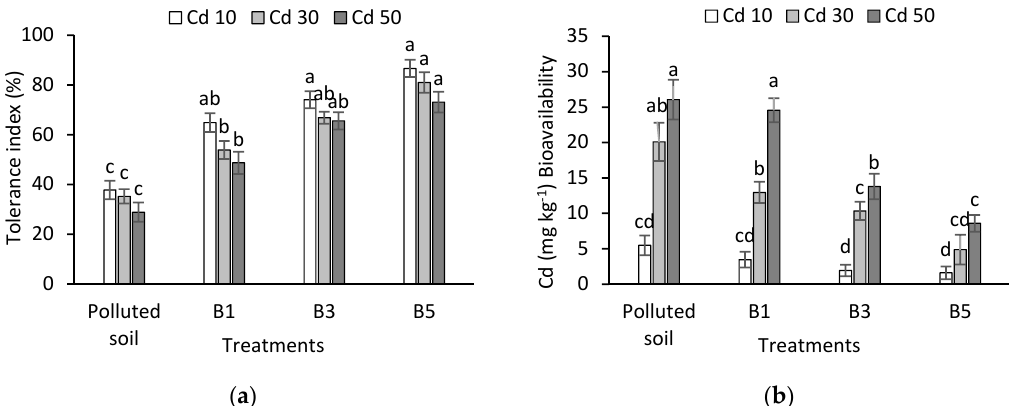
Figure 4. Effect of different levels of biochar on: ( a ) tolerance index and ( b ) bioavailability of Cd in oak seedlings at different levels of Cd contamination (means + / - one standard error). The term “Polluted soil” indicates pots with the Cd but without biochar. Different letters represent significant differences between treatments.